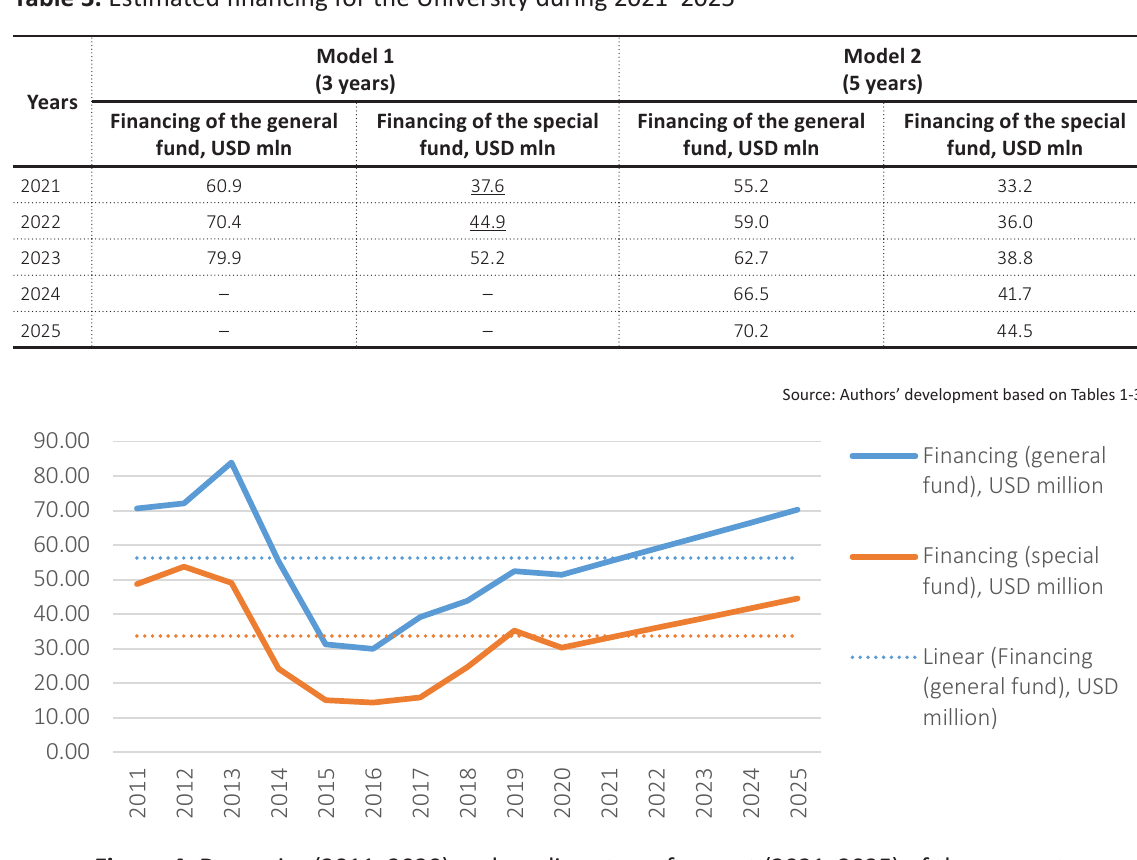
Figure 4. Dynamics (2011–2020) and medium-term forecast (2021–2025) of the amount of the University’s funding under the general and special fund, USD mln